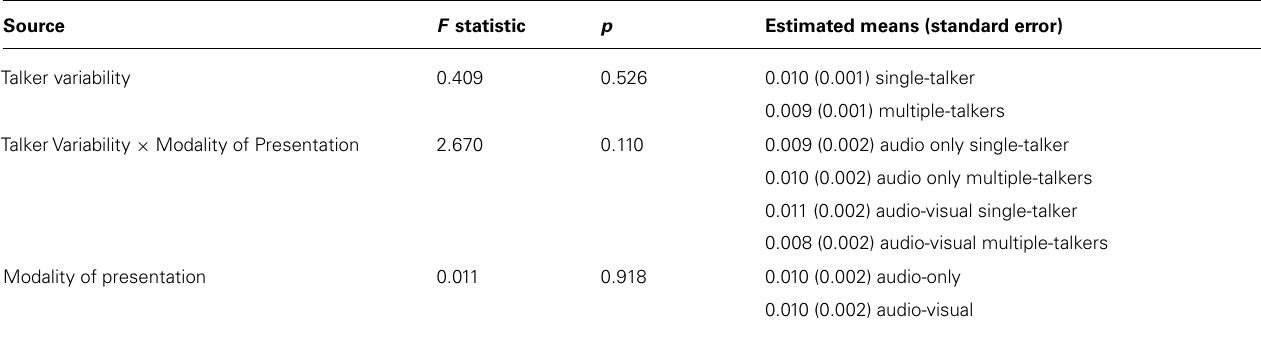
Table 1 | Summary of results from the split plotANOVA [TalkerVariability (Single-Talker vs. Multiple-Talkers) × Modality of Presentation (Audio-only vs.Audio-visual), withTalkerVariability as a within-subject factor and Modality of Presentation as a between-subject factor] for the dependent measure of false alarm rates.